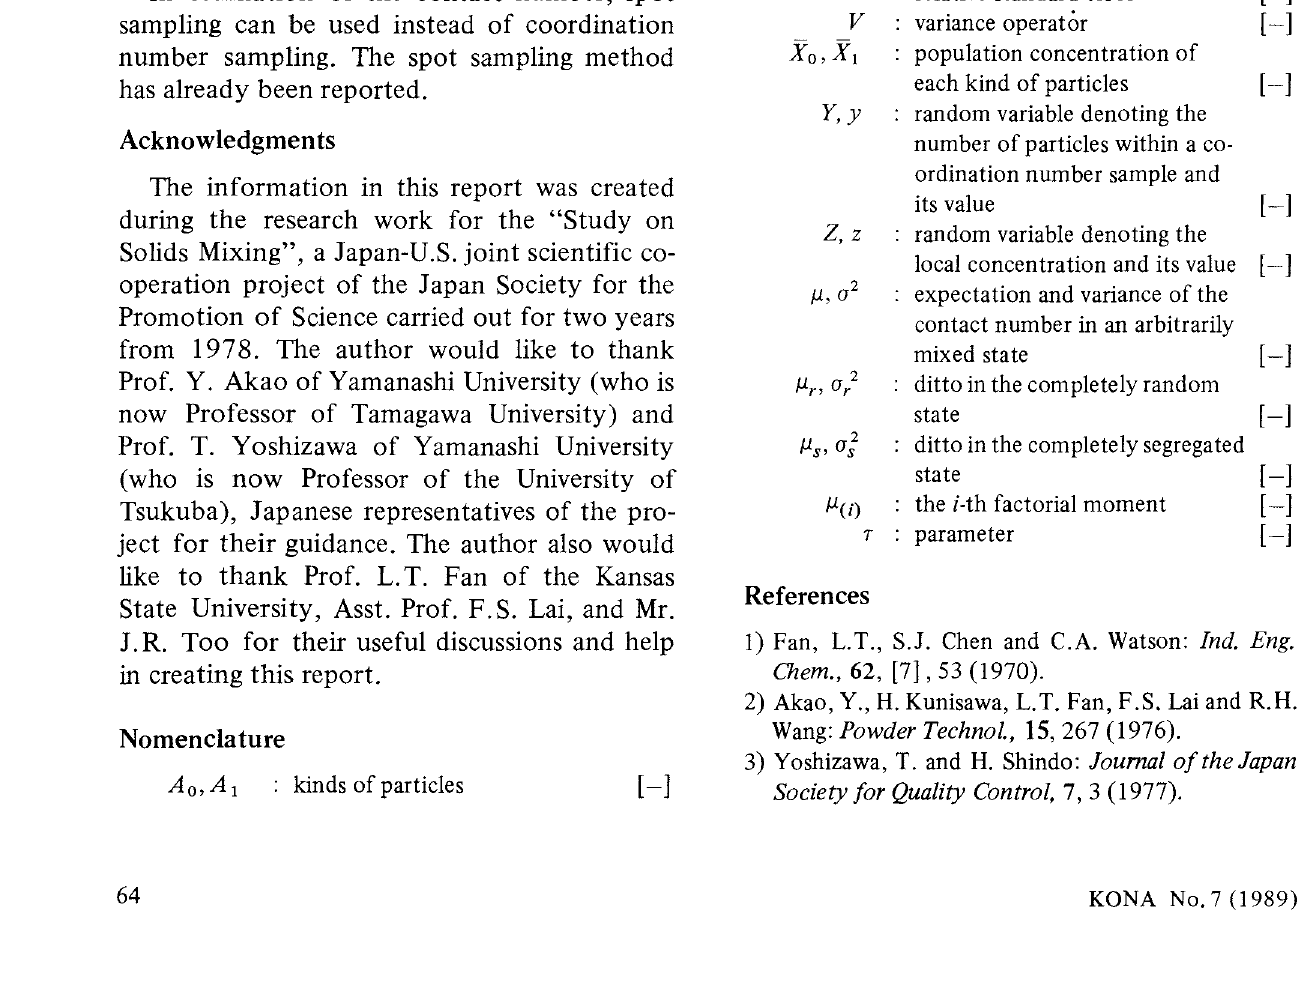
Fig. 4 Relative standard errors vs the mixing index in the case of a constant number of samples